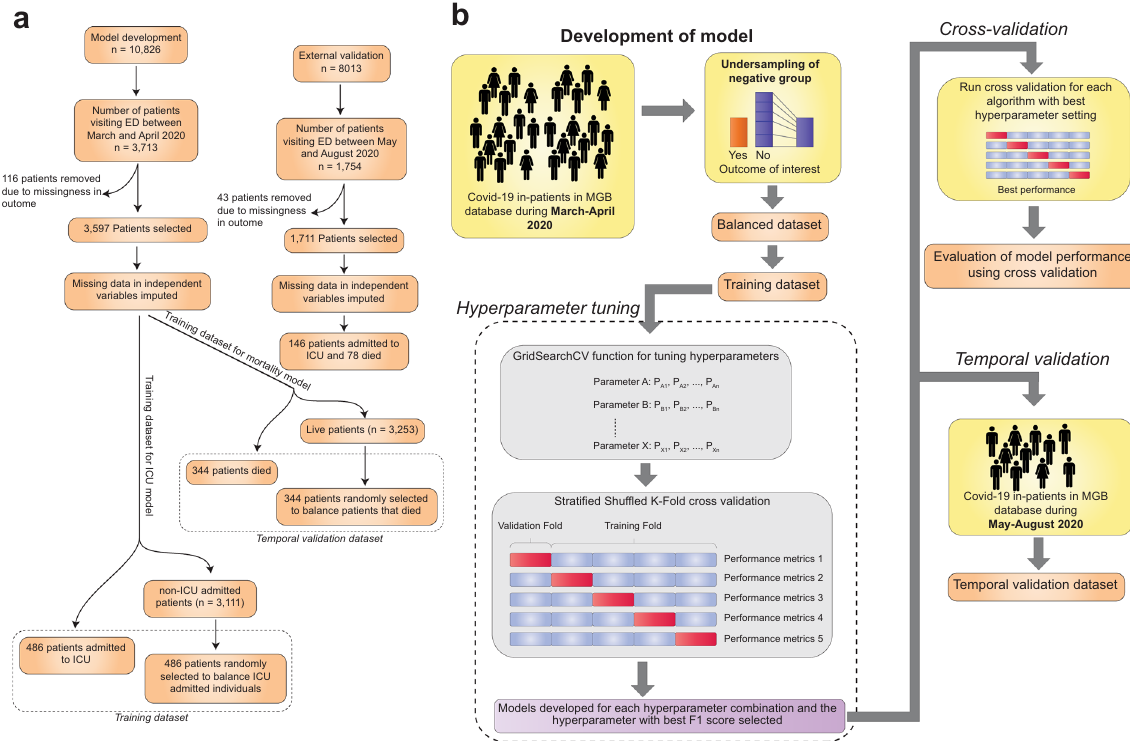
Fig. 1 Schematic diagram representing the process of machine learning model development. a Flow diagram depicting steps in obtaining the training and temporal validation datasets (with patient numbers in each step). b The process of patient selection, dataset balancing, hyperparameter tuning, cross-validation and temporal validation are